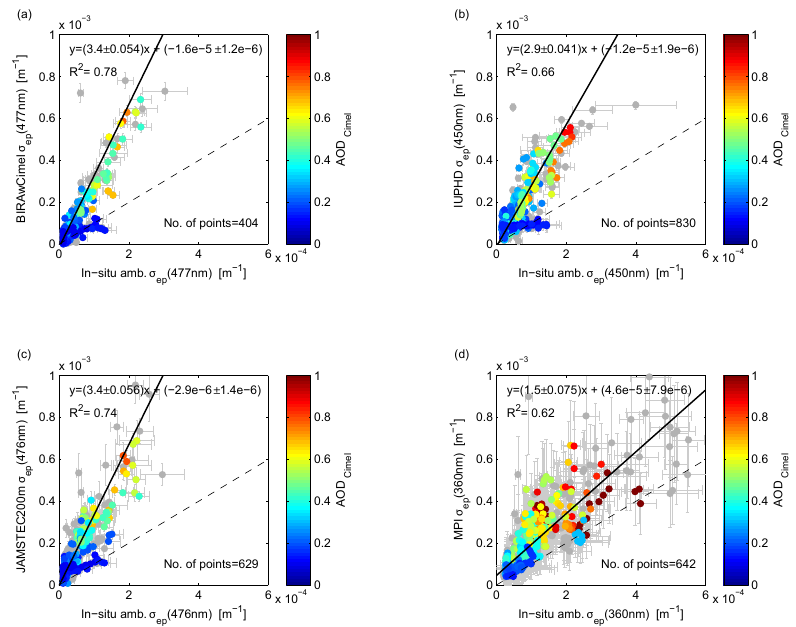
Fig. 8. Ambient extinction coefficient retrieved by MAX-DOAS vs. in-situ measurements brought to ambient conditions. The color code denotes the AOD measured by the Cimel sun photometer (AOD interpolated in accordance with the appropriate wavelength; grey points are times with no sun photometer measurements). The solid black line represents a bivariate linear regression including weights (with calculated uncertainty of slope and intercept). The dashed line is the 1:1-line.